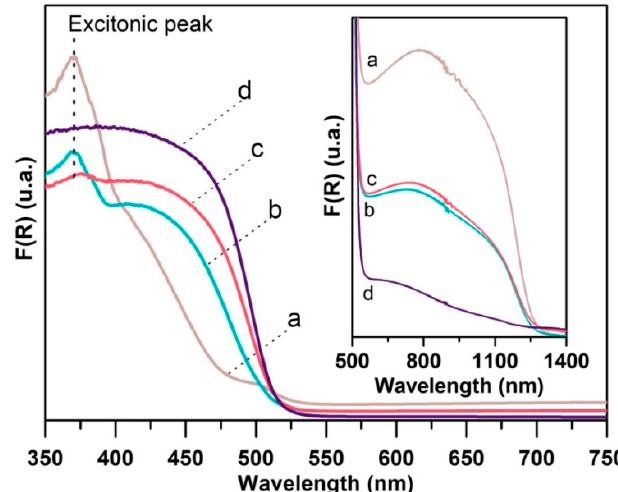
Figure 4. UV–vis spectra of AgCdS-T photocatalysts: ( a ) T = 90 °C; ( b ) T = 120 °C; ( c ) T = 150 °C; and ( d ) T = 190 °C.